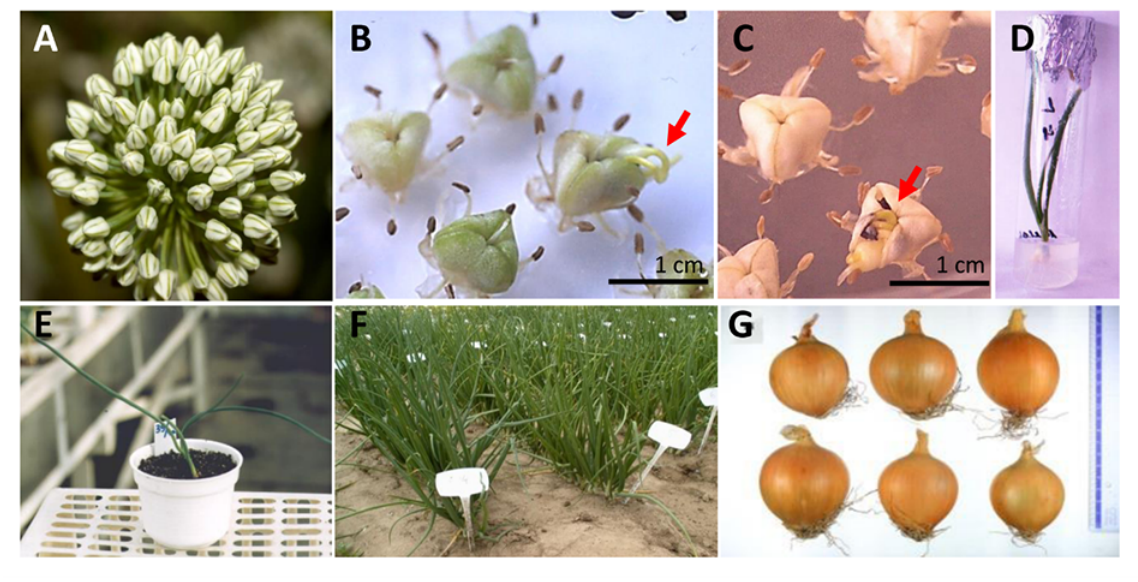
Figure 11 Gynogenesis in whole flower bud culture of Allium cepa L. ( A ) Inflorescence of onion with buds suitable for gynogenesis. ( B,C ) Gynogenic embryos (arrows) emerging from enlarged greenish or parchment ovaries plated on solid media. ( D ) Plantlet regenerated from embryos. ( E ) DH plant aer acclimatization. ( F,G ) DH lines in the field experiment and bulb